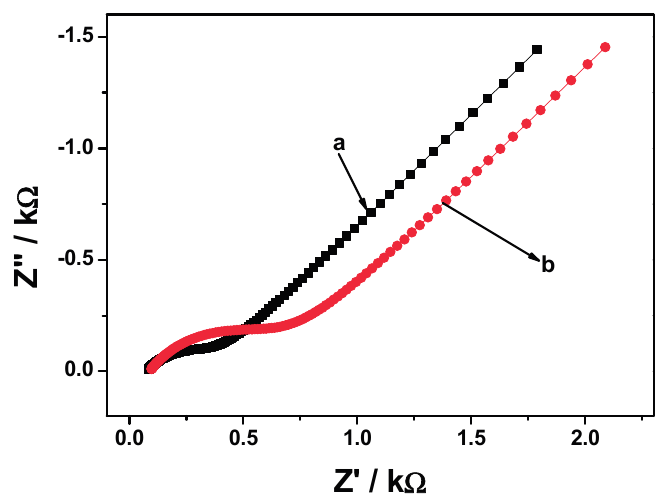
Figure 8. Nyquist plots of GCE/PT-PDMA-MWCNT after antibody immobilisation (curve a) and after immobilisation and blocking with BSA (curve b) in solution of 3 × 10 − 5 μ M of FB 1.